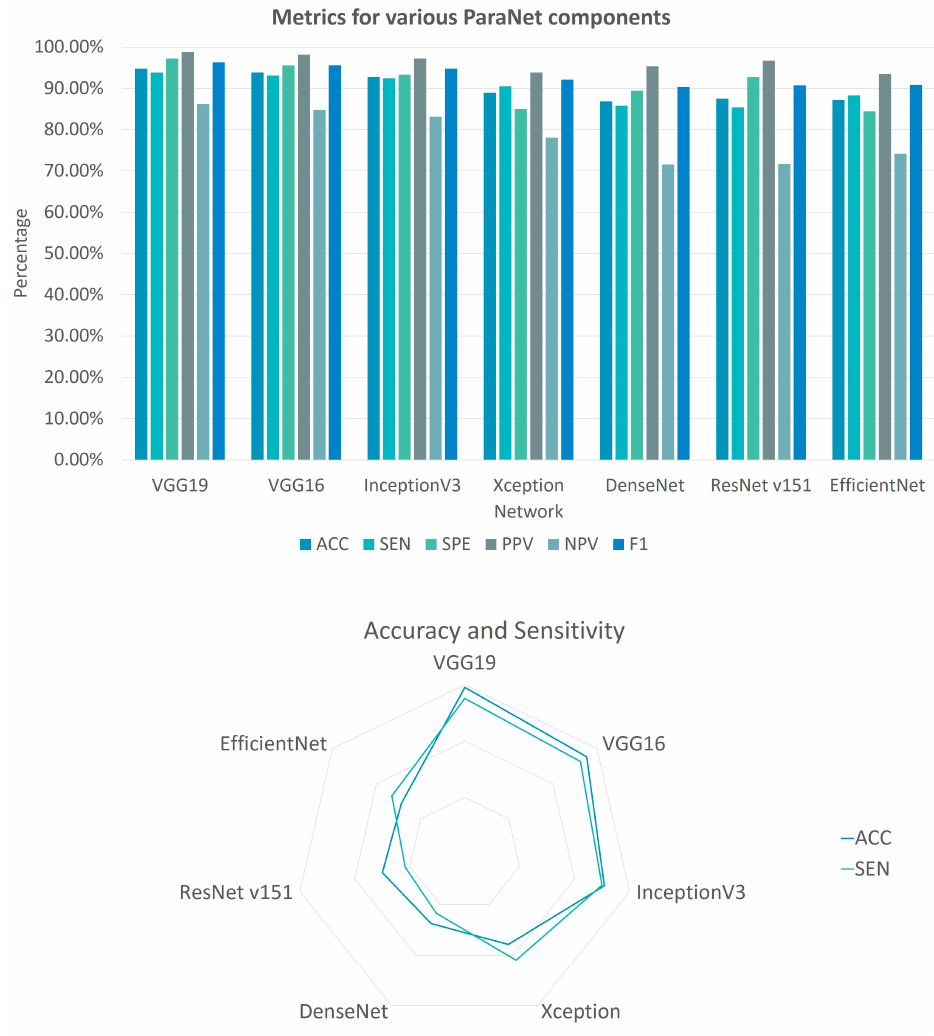
Figure 5. Metrics for various ParaNet components. The column bar plot showcases the performance of each ParaNet component in terms of accuracy (ACC), sensitivity (SEN), specificity (SPE), positive predicting value (PPV), negative predicting value (NPV) and F1 score (F1). The radar plot visualises the performance of each component in terms of ACC and SEN.